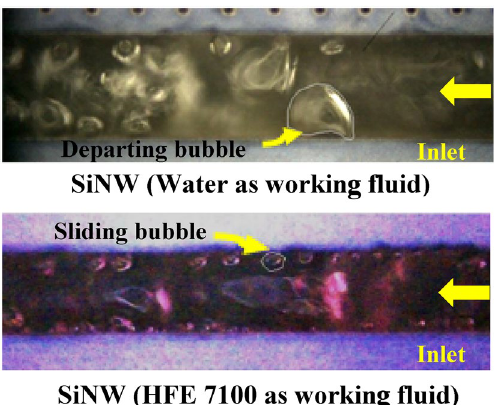
Figure 1. Bubble growth mechanism in flow boiling SiNW microchannels using water and HFE-7100 as working fluids.